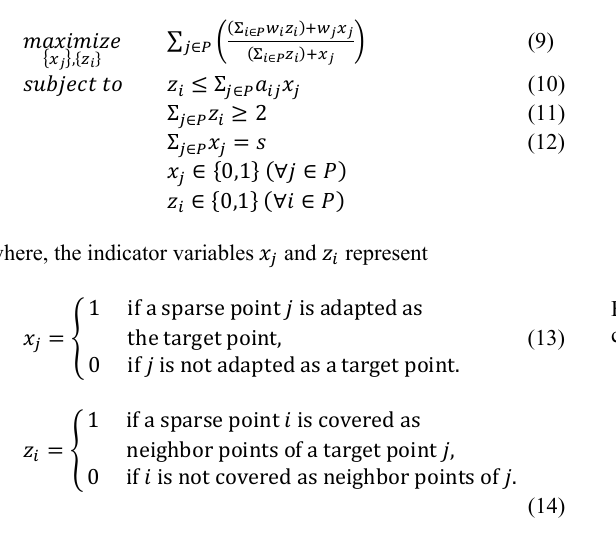
Figure 7. The estimated geometry degradation indicator value.